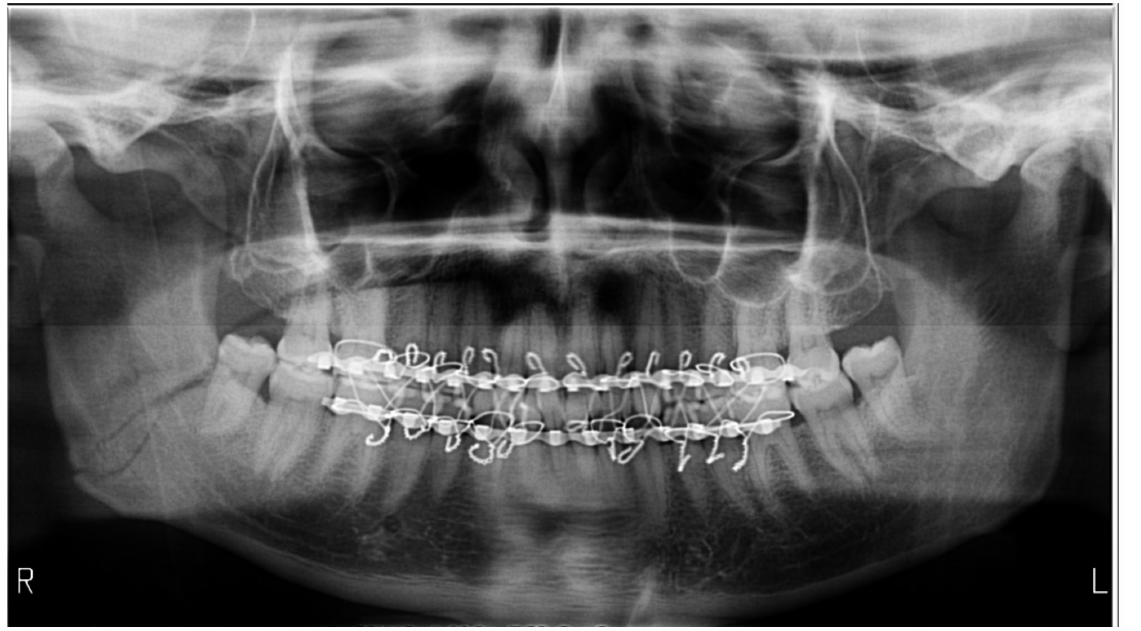
Figure 5. Orthopantomography of a patient with a fracture on the right angle of the mandible; bimaxillary immobilized exemplifies an improper adjustment in the focal through due to the absence of the bite-block, resulting in a blurry contour of the teeth, more obvious in the frontal region. Additionally, the image shows a head position in extension and incorrect exposure